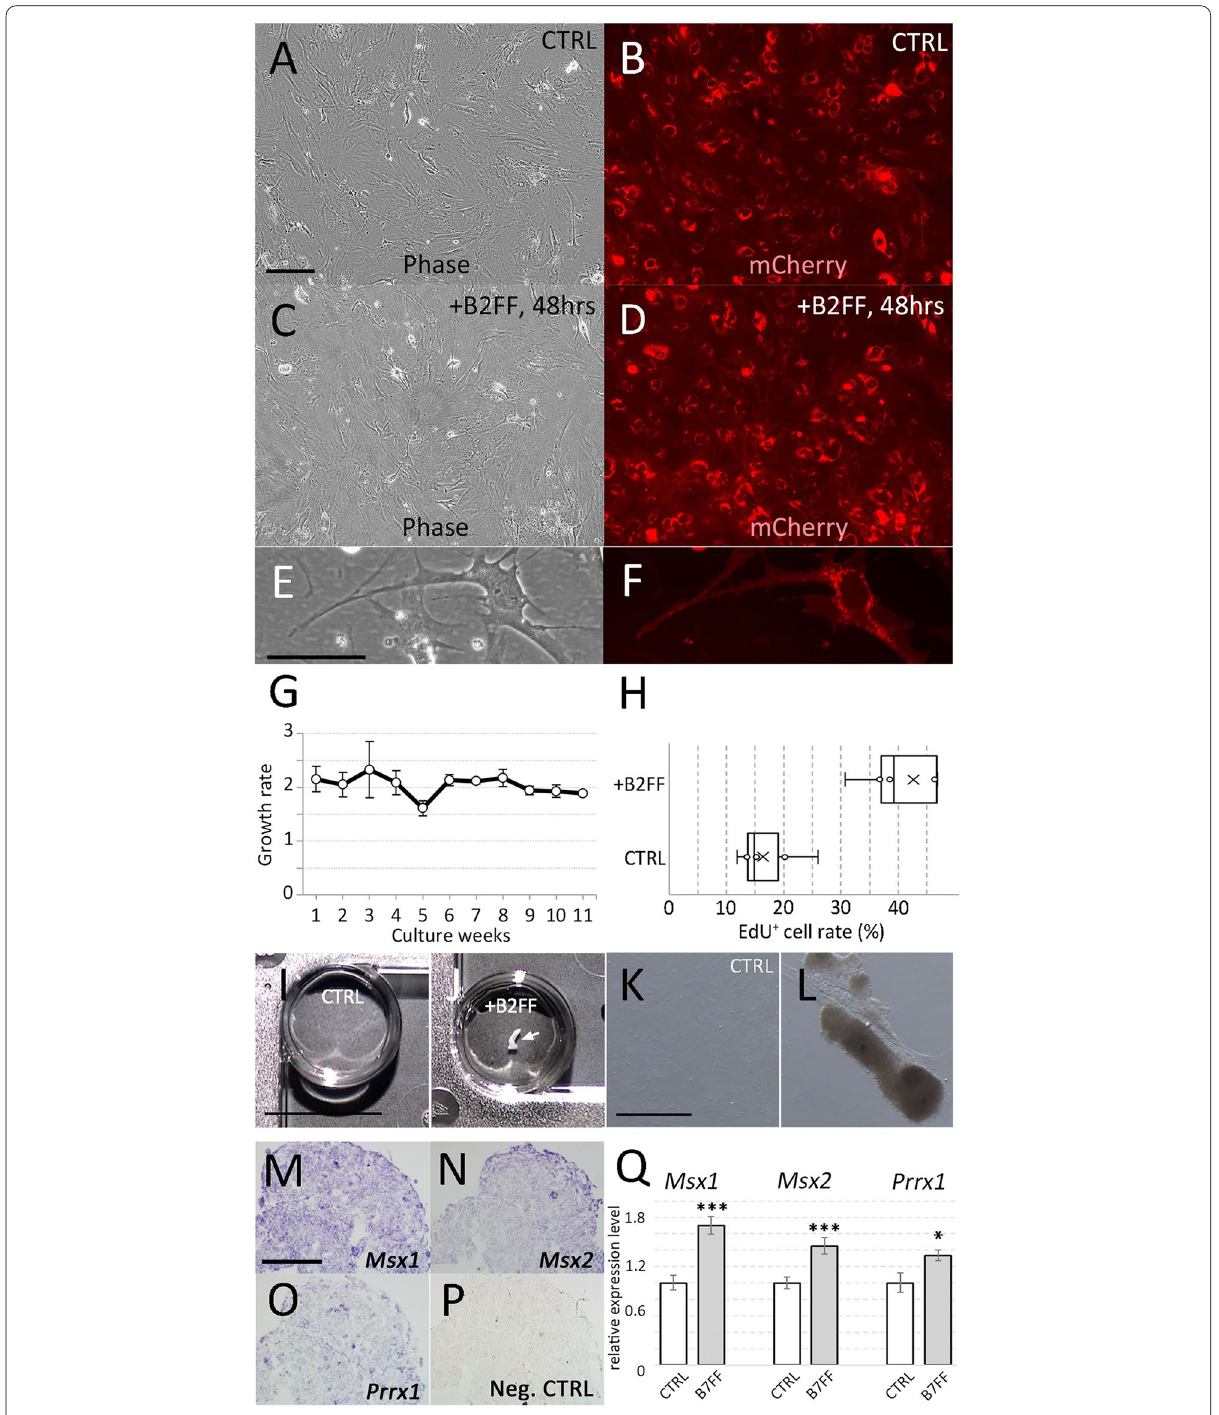
(Fig. 3B). Filamin-binding LIM protein (Fblim), Lysyl Oxi- dase Like 2 (Loxl2), Phosphodiesterase 4B (Pde4b), Sprouty RTK Signaling Antagonist 1 (Spry1), Tissue inhibitor